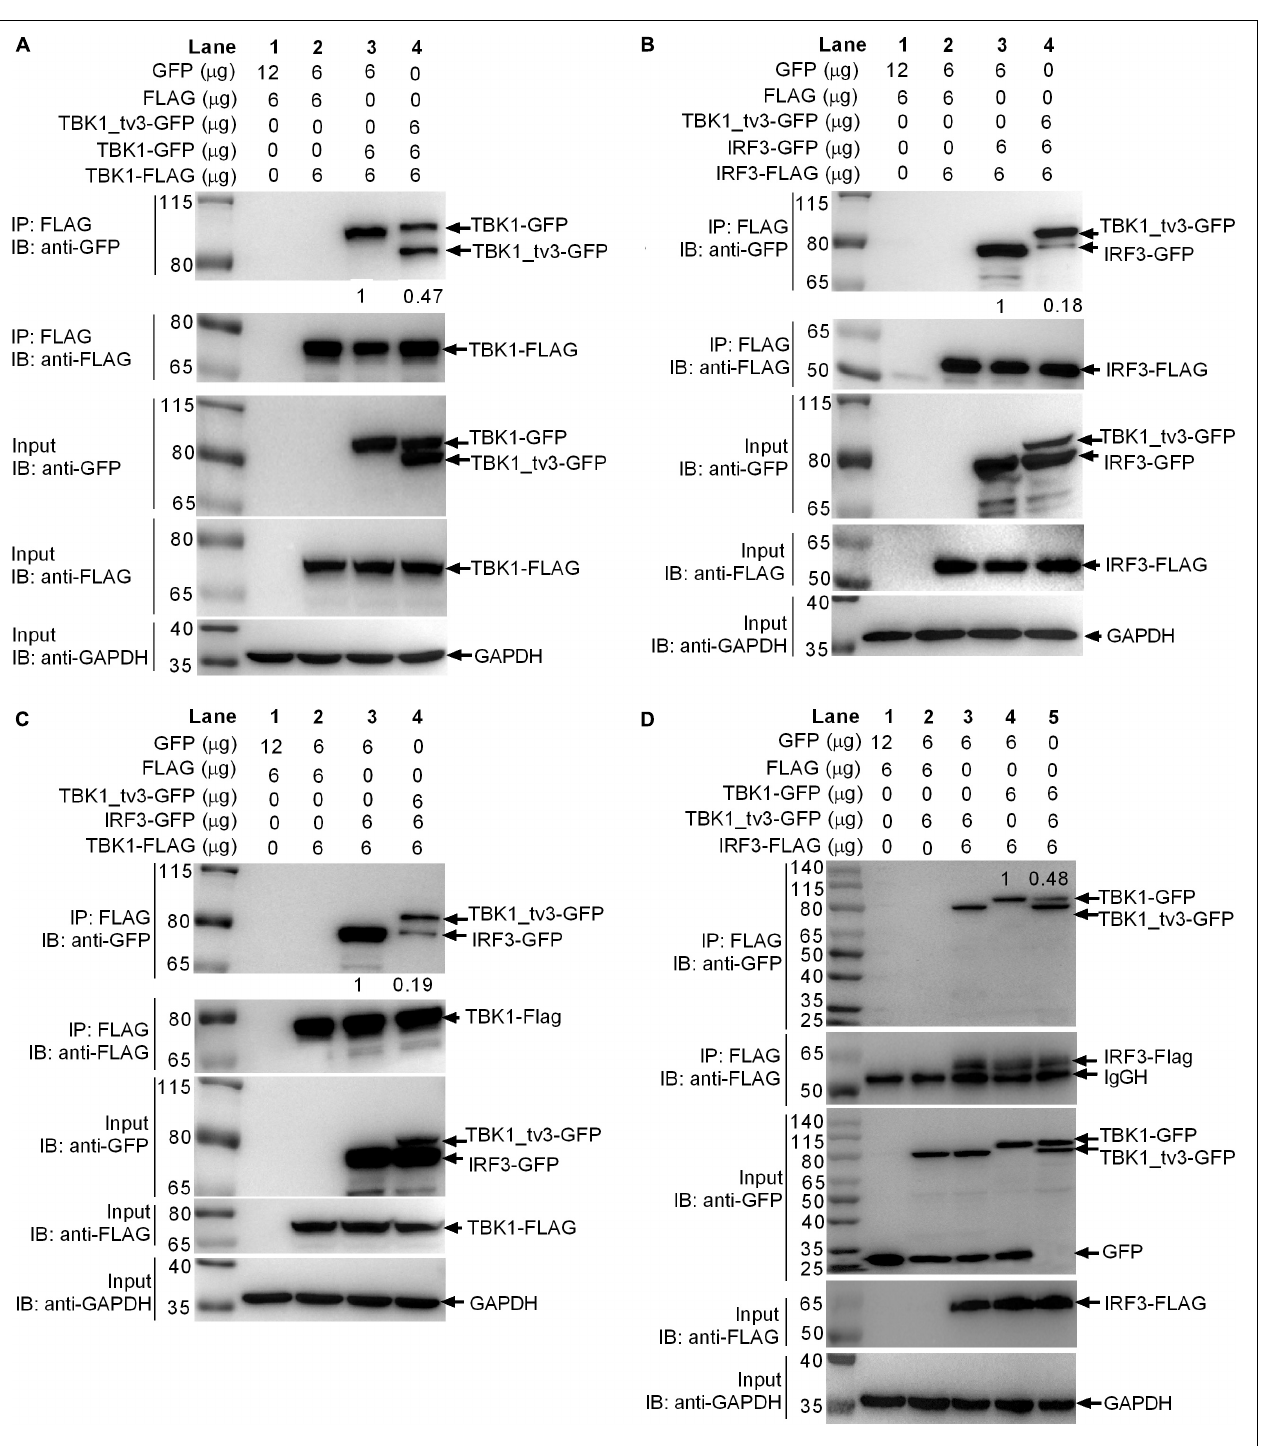
FIGURE 4 | TBK1_tv3 interacts with TBK1 and IRF3 to disrupt the formation of TBK1 homodimers, IRF3 homodimers, and TBK1–IRF3 complex. (A) TBK1_tv3 inhibited the formation of TBK1 homodimers. (B) TBK1_tv3 inhibited the formation of IRF3 homodimers. (C) TBK1_tv3 interacted with TBK1 to inhibit the formation of TBK1–IRF3 complex. (D) TBK1_tv3 interacted with IRF3 to inhibit the formation of TBK1–IRF3 complex. For A–D , co-IP was performed with anti-FLAG-conjugated agarose beads in EPC cells. The cell lysates and bound proteins were analyzed by immunoblotting with the indicated Abs. The expression ratio was quantified by Quantity One. All experiments were repeated for at least three times with similar results.